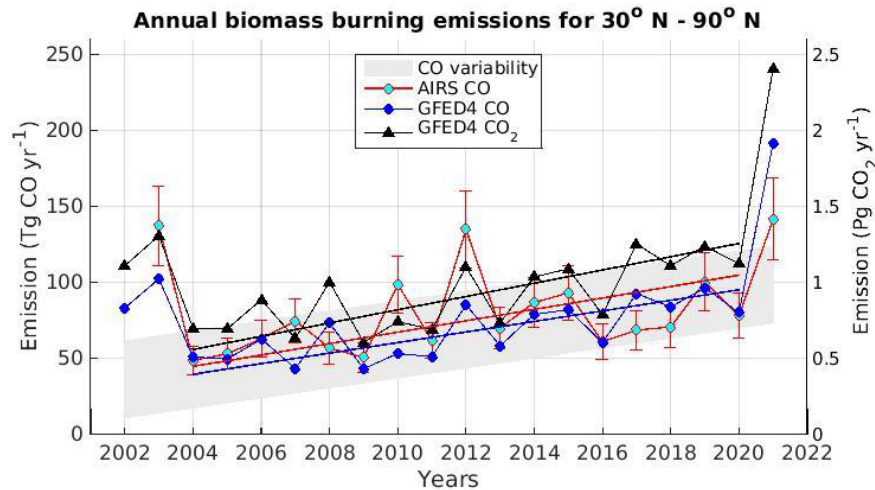
Figure 6. Annual CO emitted by fires in HNH according to AIRS data and bottom-up GFED4c estimates [3]. CO 2 emissions (right scale) [3] are plotted for comparison. Least-squares regression lines are also shown. Error bars are derived from the validation and are estimated as ± 19%. The shaded area corresponds to GFED4c CO ± 2 STD (standard deviation) of the yearly points.